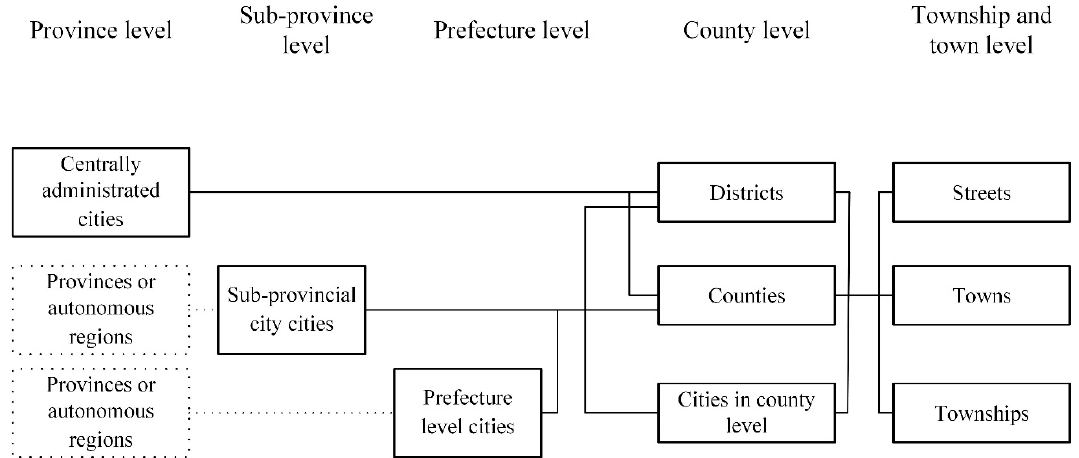
Figure 1. Administrative and spatial structure system of China’s municipality.